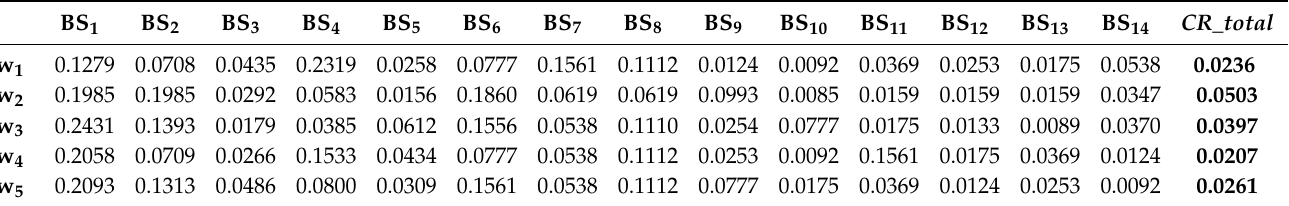
Table A20. The hierarchical total sorting results of all business scenarios. The CR_total of each hierarchical total sorting is in